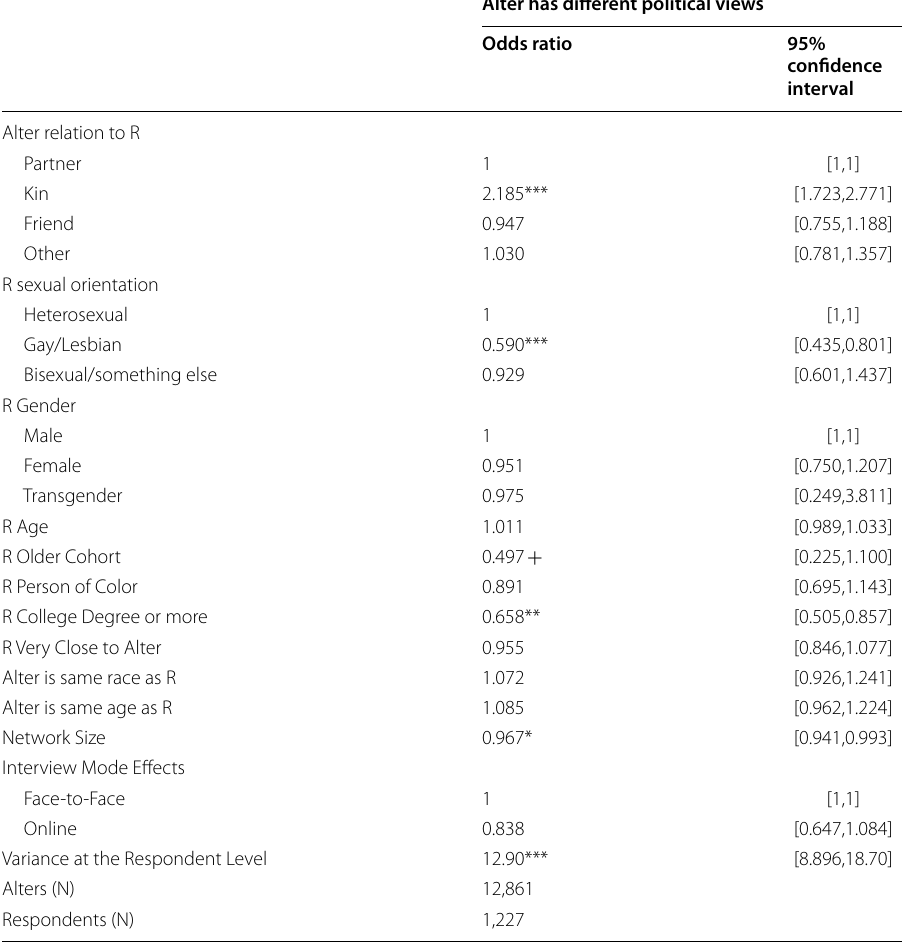
Table 4 Estimates of the likelihood that alters hold different political views than the respondent,